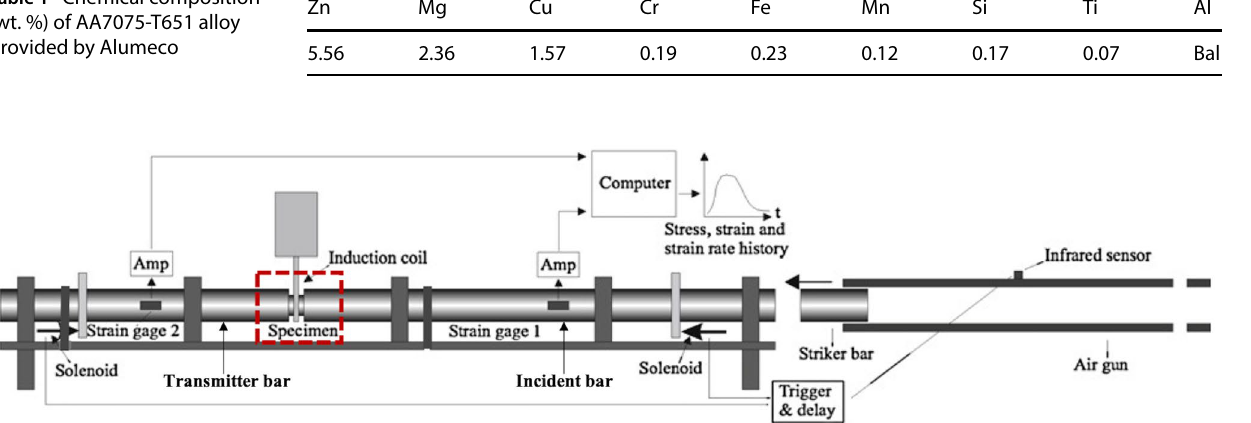
Table 1 Chemical composition (wt. %) of AA7075-T651 alloy provided by Alumeco